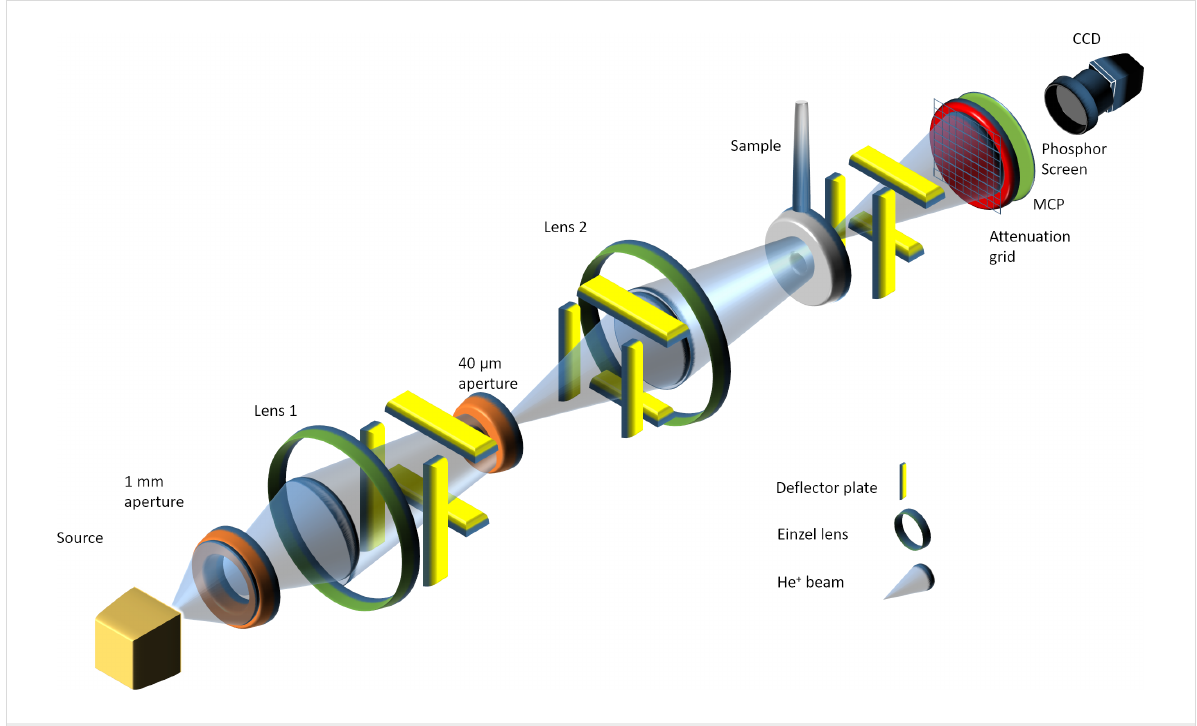
Figure 1: Schematic of the transmission helium ion microscope (THIM).